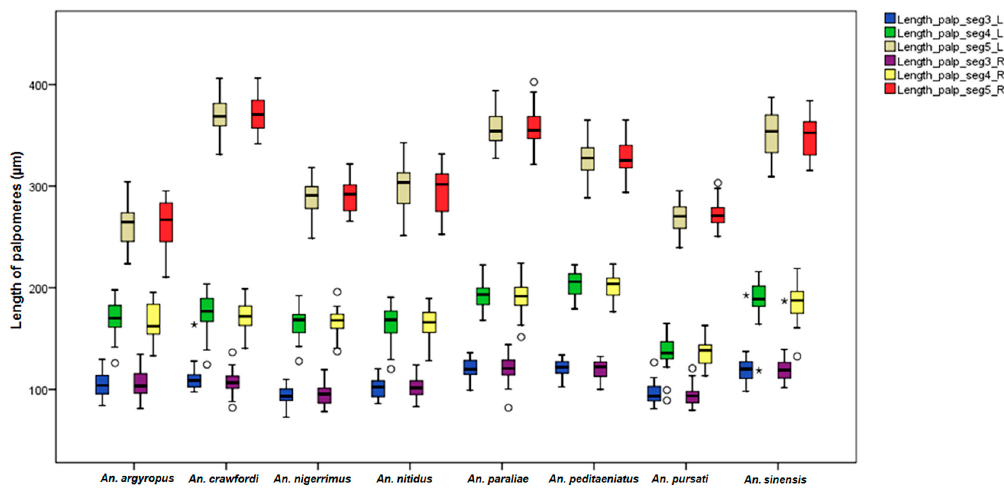
Figure 6. The Box-and-Whisker Plots representation of variation in maxillary palpomeres length of adult female of the eight Hyrcanus Group species.